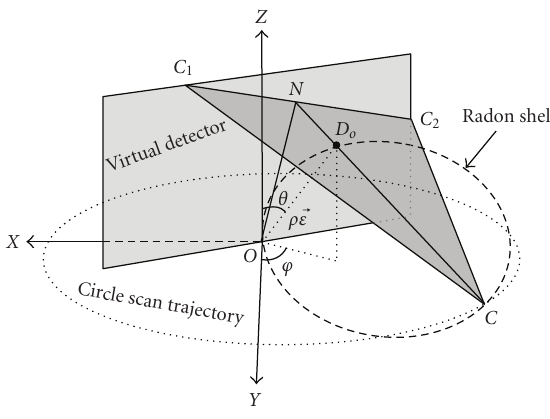
Figure 1: Illustration of 3-D Radon transform and Radon shell in object